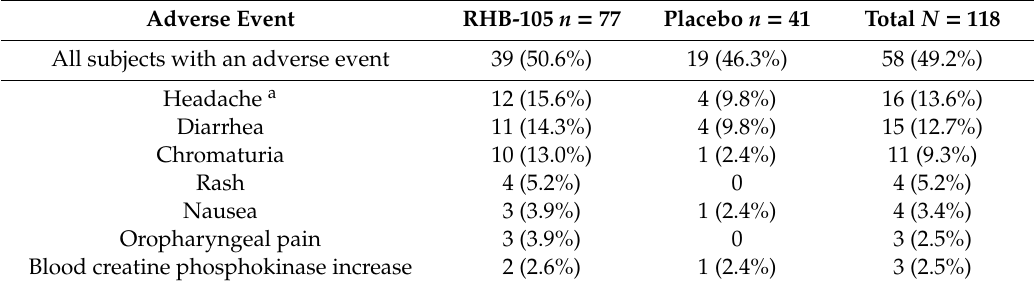
Table 4. Adverse Events Occurring in > 2% of All Subjects and in a Greater Percentage of RHB-105 Subjects than Placebo